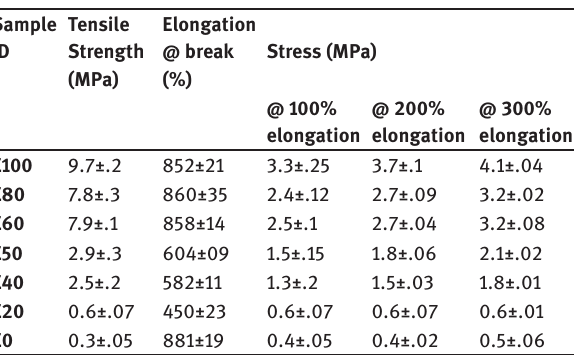
Table 3: Comparison of Physico-mechanical properties of NBR/EMA